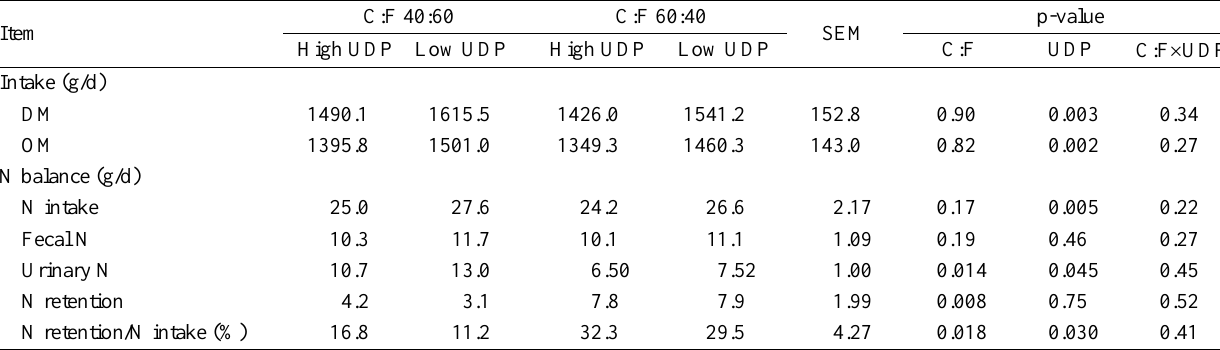
Table 2. Nutrient intakes and nitrogen balance in lambs fed diets differing in C:F and level of UDP